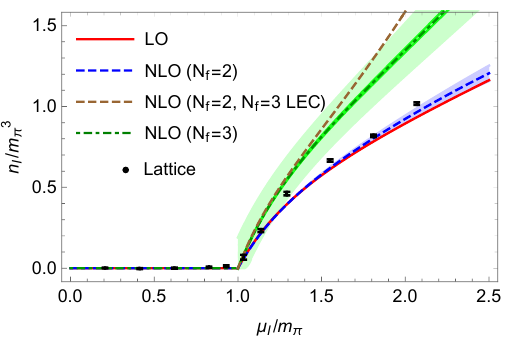
Figure 5 . Normalized isospin density ( n I =m 3 ) as a function of (cid:22) I =m (cid:25) at LO (red), at NLO with (cid:25) two (cid:13)avors (blue), NLO with three (cid:13)avors (green), and NLO with two (cid:13)avors and three-(cid:13)avor LECs (brown). See main text for details.